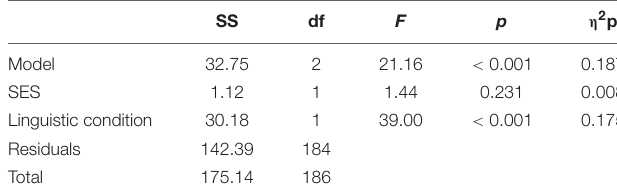
TABLE 1 | Effect of linguistic condition on notational skills by controlling